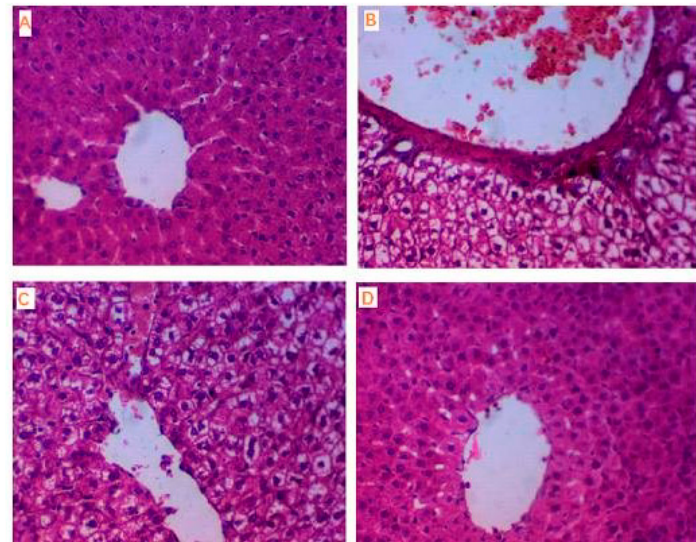
Figure 8. (A) Normal liver control. Photomicrograph of normal liver tissue showing normal size central vein ( ↕ ) surrounded by rows and cords of normal hepatocytes ( ↑ ) with central nuclei and abundant eosinophilic cytom. (H&E stain ×400). (B) Positive control DM Liver. Photomicrograph of liver tissue of diabetic rat showing markedly dilated congested central vein ( ↕ ) filled with red blood cells and surrounded by aggregates of inflammatory cells with rows and cords of hepatocytes showing severe fatty change ( ↑ ). (H&E stain ×400). (C) Liver of treated group with VOSO 4 . Photomicrograph of liver tissue from a diabetic rat treated with only VOSO 4 , showing moderately dilated congested central vein ( ↕ ) surrounded by rows and cords of hepatocytes showing moderate degree of fatty change ( ↑ ). (H&E stain ×400). (D) Liver of treated group with NH 4 [(VO)(FA)(AA 1 )] complex. Photomicrograph of liver tissue of diabetic rat treated with NH 4 [(VO)(FA)(AA 1 )] complex showing return to the normal state with a normal size of central vein ( ↕ ) surrounded by rows and cords of normal hepatocytes ( ↑ ). (H&E stain ×400).